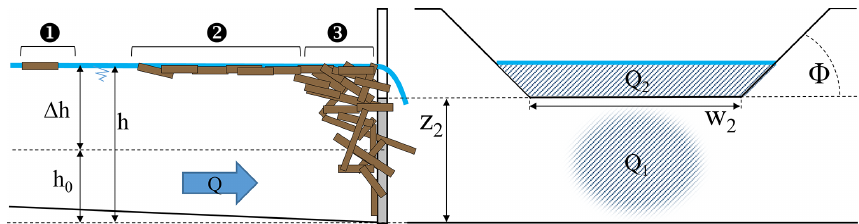
Figure 1. Notation used throughout the paper: (a) side view of LW jamming a barrier and (b) front view of barrier. Water depth without LW and with LW are denoted h 0 and h , respectively. The difference between h and h 0 is the head loss (cid:49)h . Dam crest is of height z 2 . Logs may be (1) freely flowing, (2) floating in a single layer as a carpet or (3) jamming the barrier with most pieces submerged. The total water discharge Q is split into Q 1 , the discharge passing through the dam, and Q 2 , the discharge overflowing the